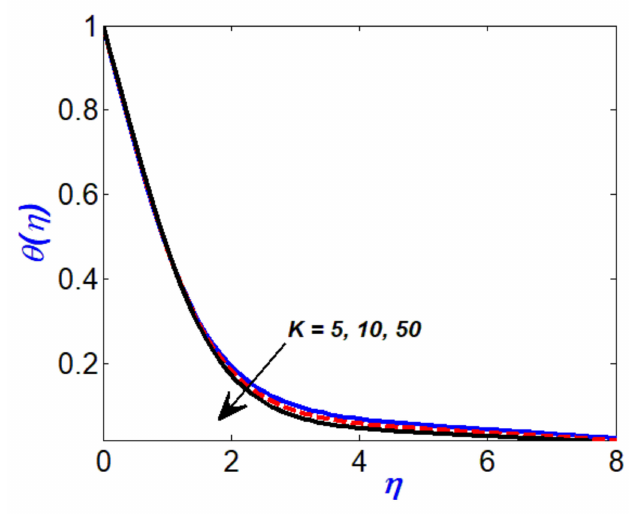
Figure 5. Temperature profile with variation in K